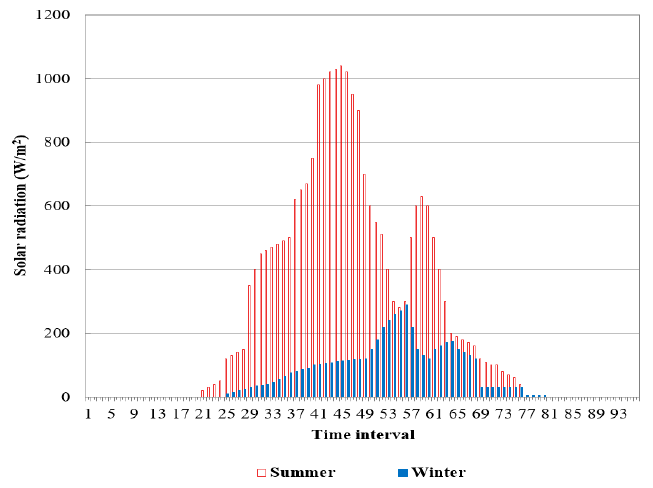
Figure 5. The solar radiation curves.